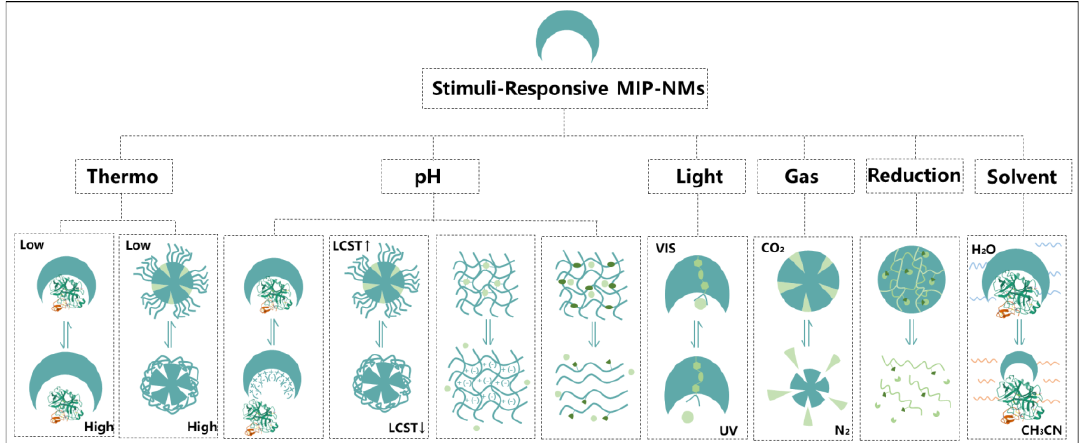
Figure 7. Schematic diagram of SR-MIPs with different stimulus responses.